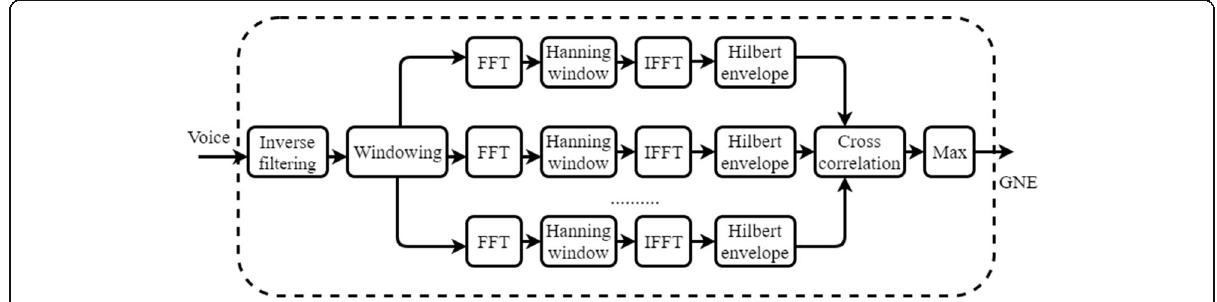
Fig. 3 Process of GNE